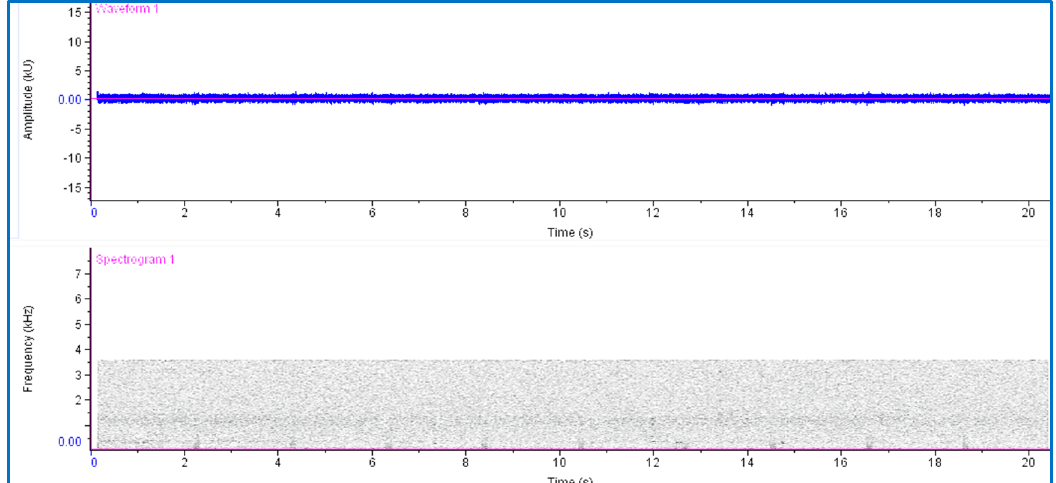
Figure 5. The oscillogram and spectrogram revealed that no sound signals were produced by RPW larval activity two months after fungal injection, unlike the signal patterns from control treatment palms.